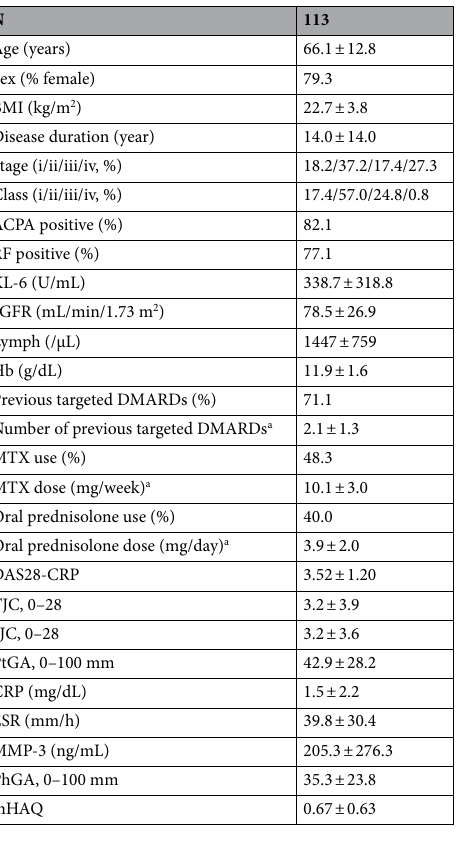
Table 1. Patient baseline characteristics. Data are presented as mean ± standard deviation unless otherwise indicated. BMI Body mass index, Stage Steinbrocker’s stage, Class Steinbrocker’s class, ACPA anti-citrullinated